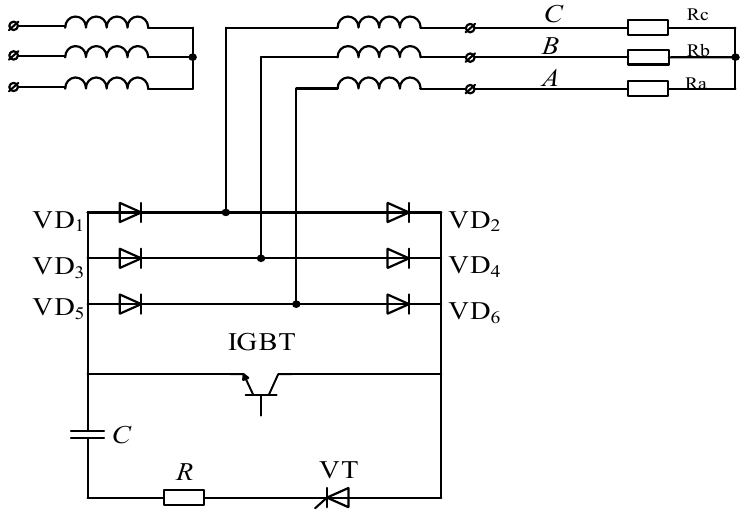
Figure 2. Neutral point switch circuit topology constituting by solid-state breaker.